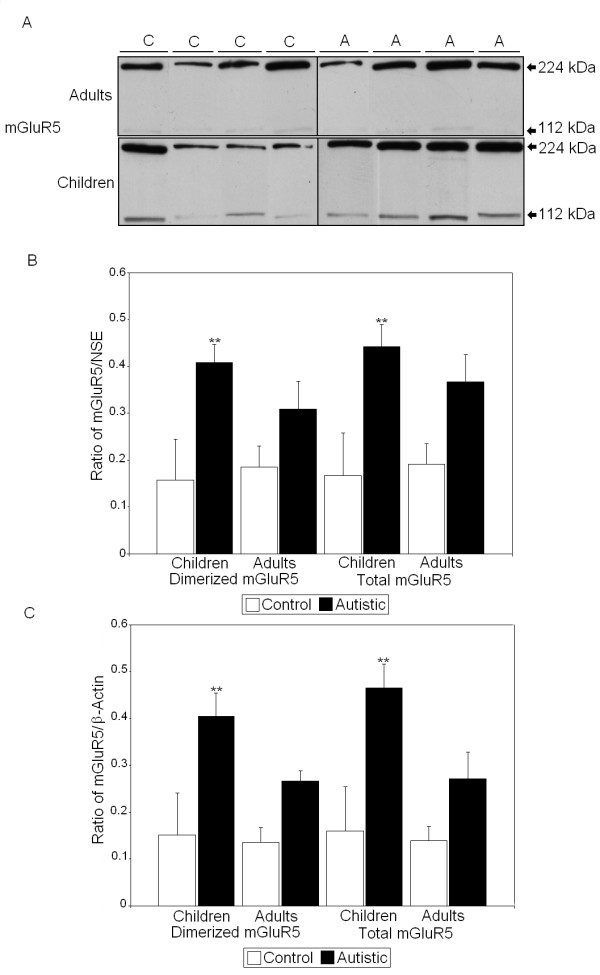
Expression of mGluR5 in superior frontal cortex of people with autism and matched controls.(A) Representative samples of metabotropic glutamate receptor 5 (mGluR5) from controls (C) and people with autism (A). (B) Mean mGluR5 dimer and monomer/neuron-specific enolase (NSE) ratios for people with autism (filled histogram bars) and controls are shown for Brodmann's area 9 (BA9). (C) Mean mGluR5/β-actin ratios for people with autism (filled histogram bars) and controls are shown for BA9. Error bars express standard error of the mean. **P < 0.05.